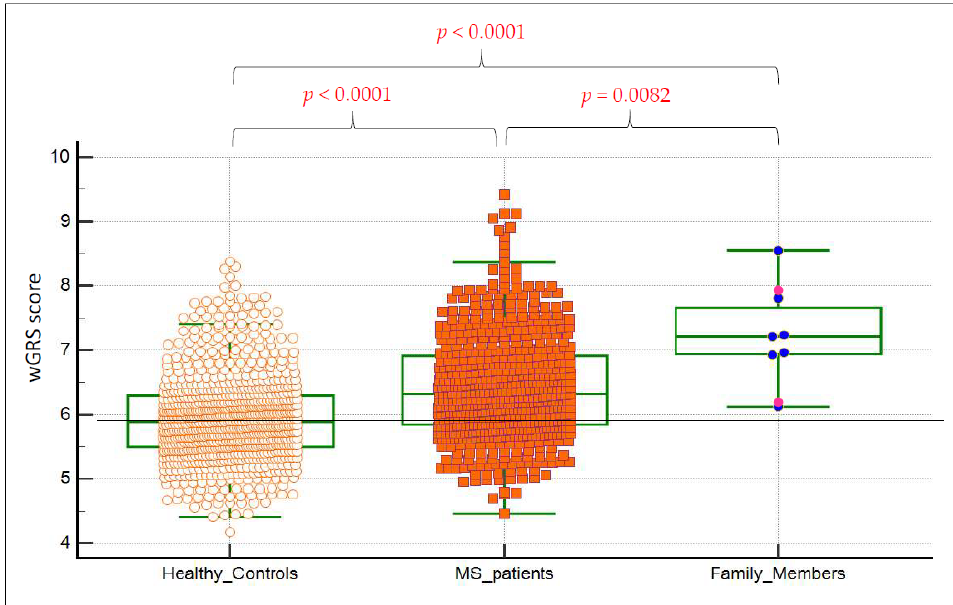
Figure 3. wGRS comparison between index family members, non-familial MS cases, and healthy controls. wGRS analysis of known common MS risk alleles. wGRS was constructed with results of 42 non-HLA SNPs and 8 HLA markers (risk alleles DRB1*15:01, 03:01, 13:03, 08:01, and the protective alleles A*02:01, B*44:02, B*38:01; B*55:01). Within the family member category, two healthy members (I.2 and III.3) were included in the distribution (bright pink dots), but they were excluded from the statistical analysis.